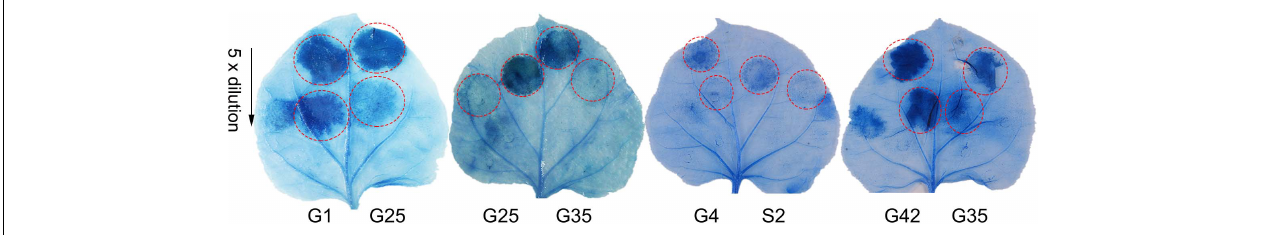
FIGURE 4 | Non-pathogenic and very low-virulent isolates within Pseudomonas syringae pv. actinidiae biovar 3 (Psa3) showed attenuated capacity to elicit a hypersensitivity response (HR) in non-host Nicotiana benthamina leaves. Four zones in half a leaf were injected with fivefold diluted bacteria (10 7 CFU/mL as the initial concentration), and three leaves from three independent plants were treated with each isolate. Photographs were taken 3 days post infiltration. Experiments were repeated at least twice with similar results.